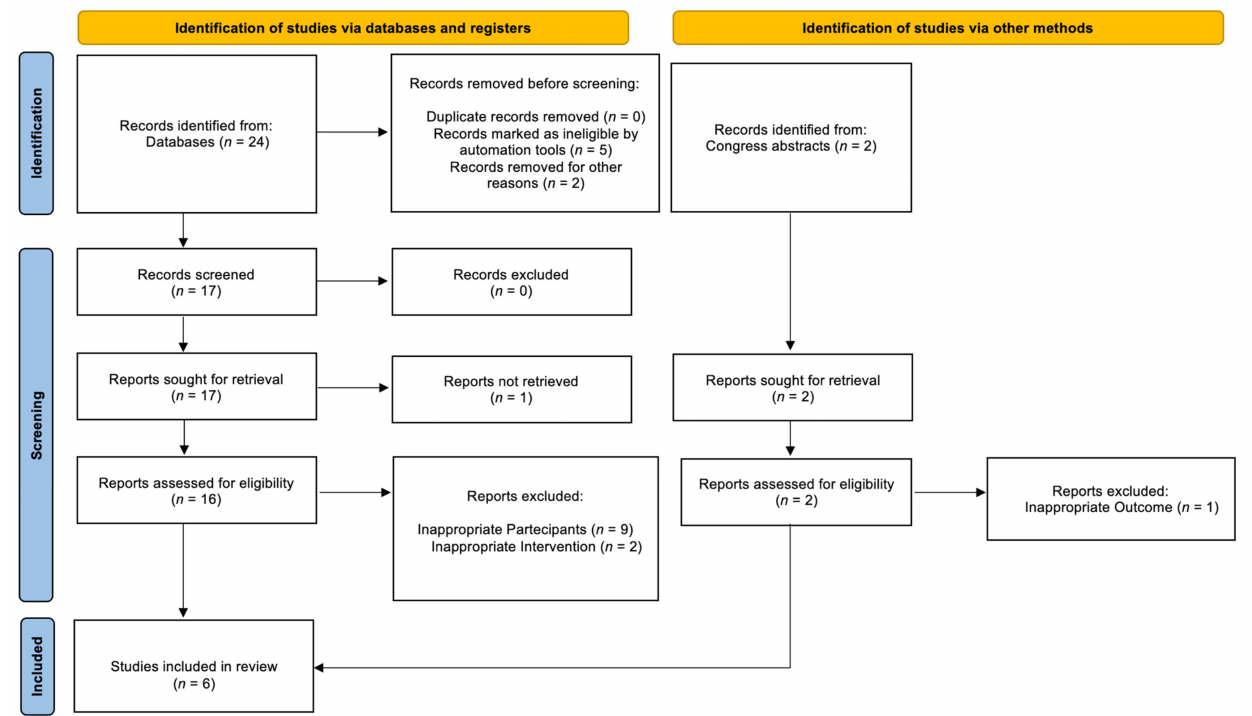
Figure 1. Flow diagram of the systematic